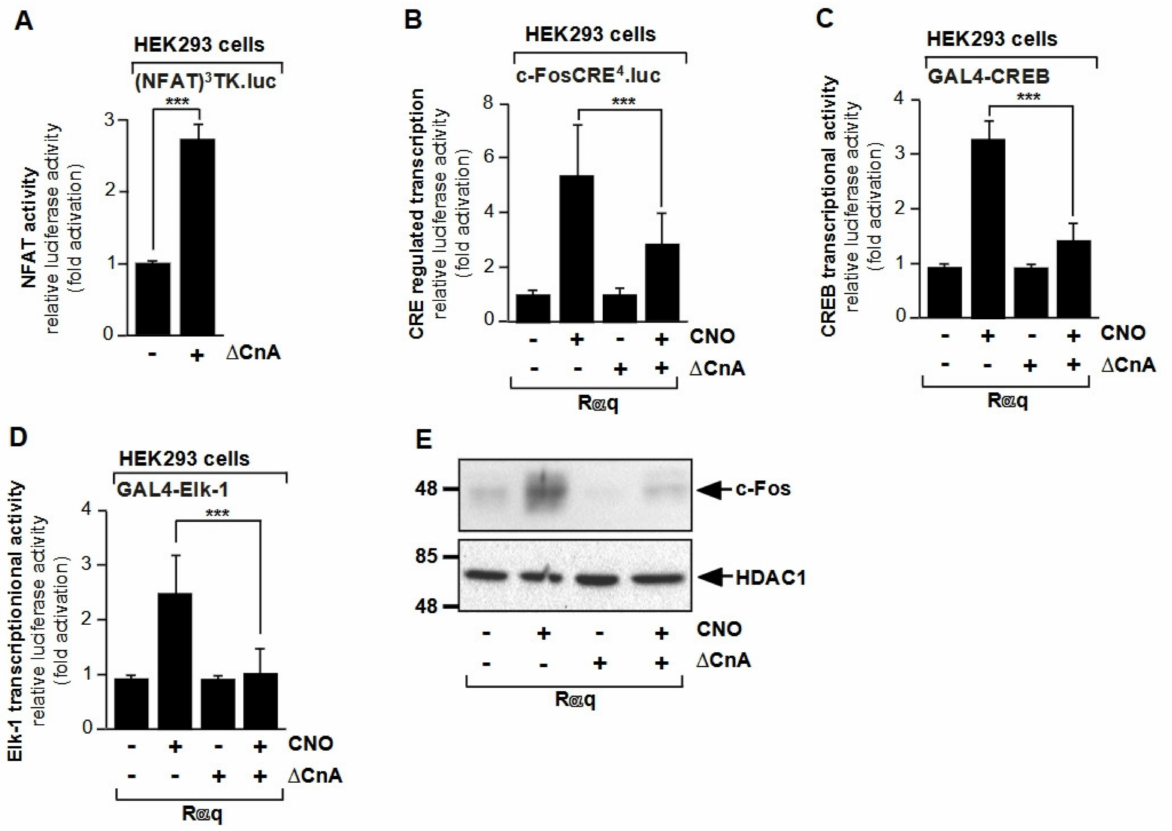
Figure 6. Regulation of gene transcription by calcineurin. ( A ) Expression of ∆ CnA, a constitutively active mutant of calcineurin A, increased transcription of an NFAT-responsive reporter gene. HEK293 cells containing a chromatin-integrated NFAT-responsive reporter gene (NFAT) 3 TK.luc were infected with a recombinant lentivirus encoding ∆ CnA. The cells were serum-starved for 24 h. Cell extracts were prepared and analyzed for luciferase activities. Luciferase activity was normalized to the protein concentration. ( B ) Calcineurin attenuates CRE-regulated gene transcription in HEK293 cells expressing activated G α q-coupled designer receptors. HEK293 cells containing a chromatin-embedded CRE-containing reporter gene (c-FosCRE 4 .luc) were infected with a lentivirus encoding a G α q-coupled designer receptor (R α q). Cells